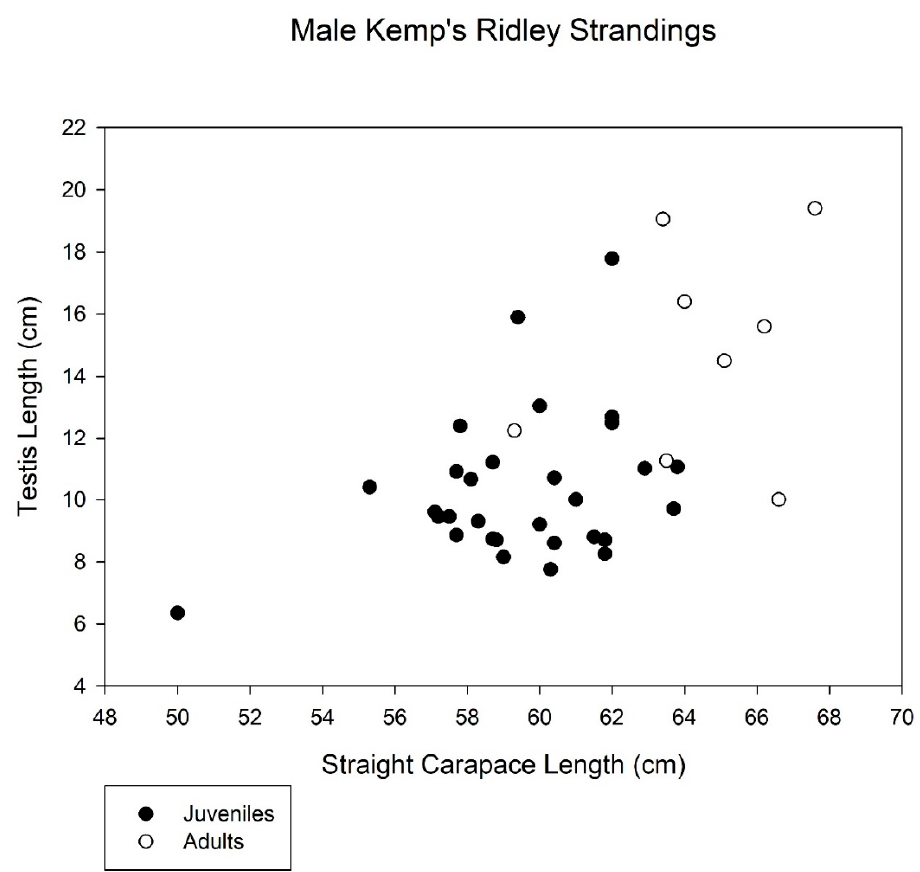
Figure 3. Comparison of testis length and straight carapace length measured in male Kemp’s ridley turtles, Lepidochelys kempii , found stranded in Texas, USA, from 1994 through 1999.